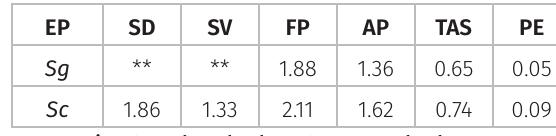
Table I. Morphometry of eyelid structures in Sotalia guianensis (Sg) and Stenella clymene (Sc), in